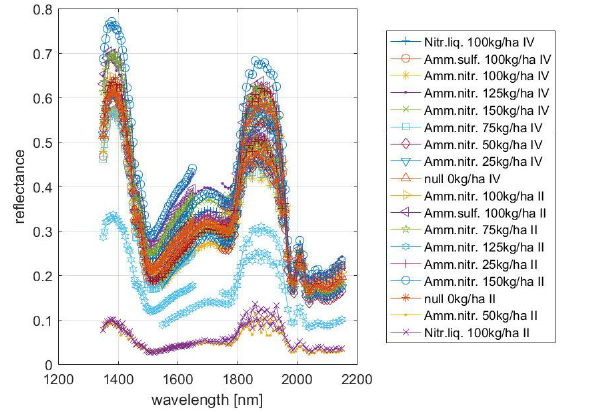
Figure 15 Measured spectral reflectances of grass test plots Figure 12 Measured spectral reflectances of two leaves of with different Nitrogen fertilizer amounts measured on uninfected control pea plant and two leaves of an infected pea 1.8.2017 at the Luke Jokionen grass test field with Spectral plant. Engines microspectroemeter modules SE-N1.7, SE-N2.0 and SE-N2.2.